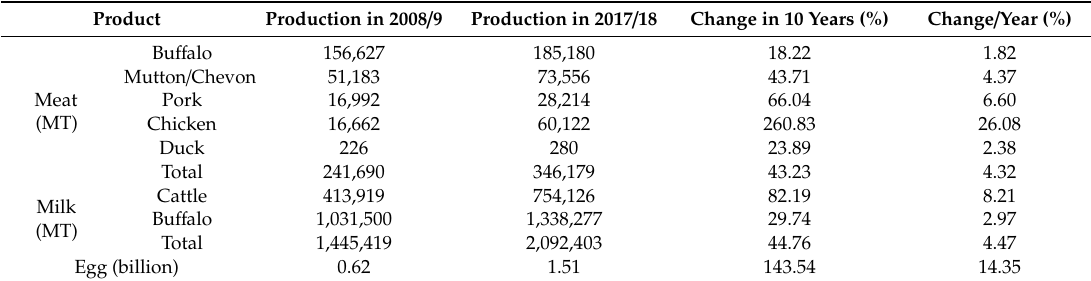
Table 2. Milk, meat, and egg productions in Nepal